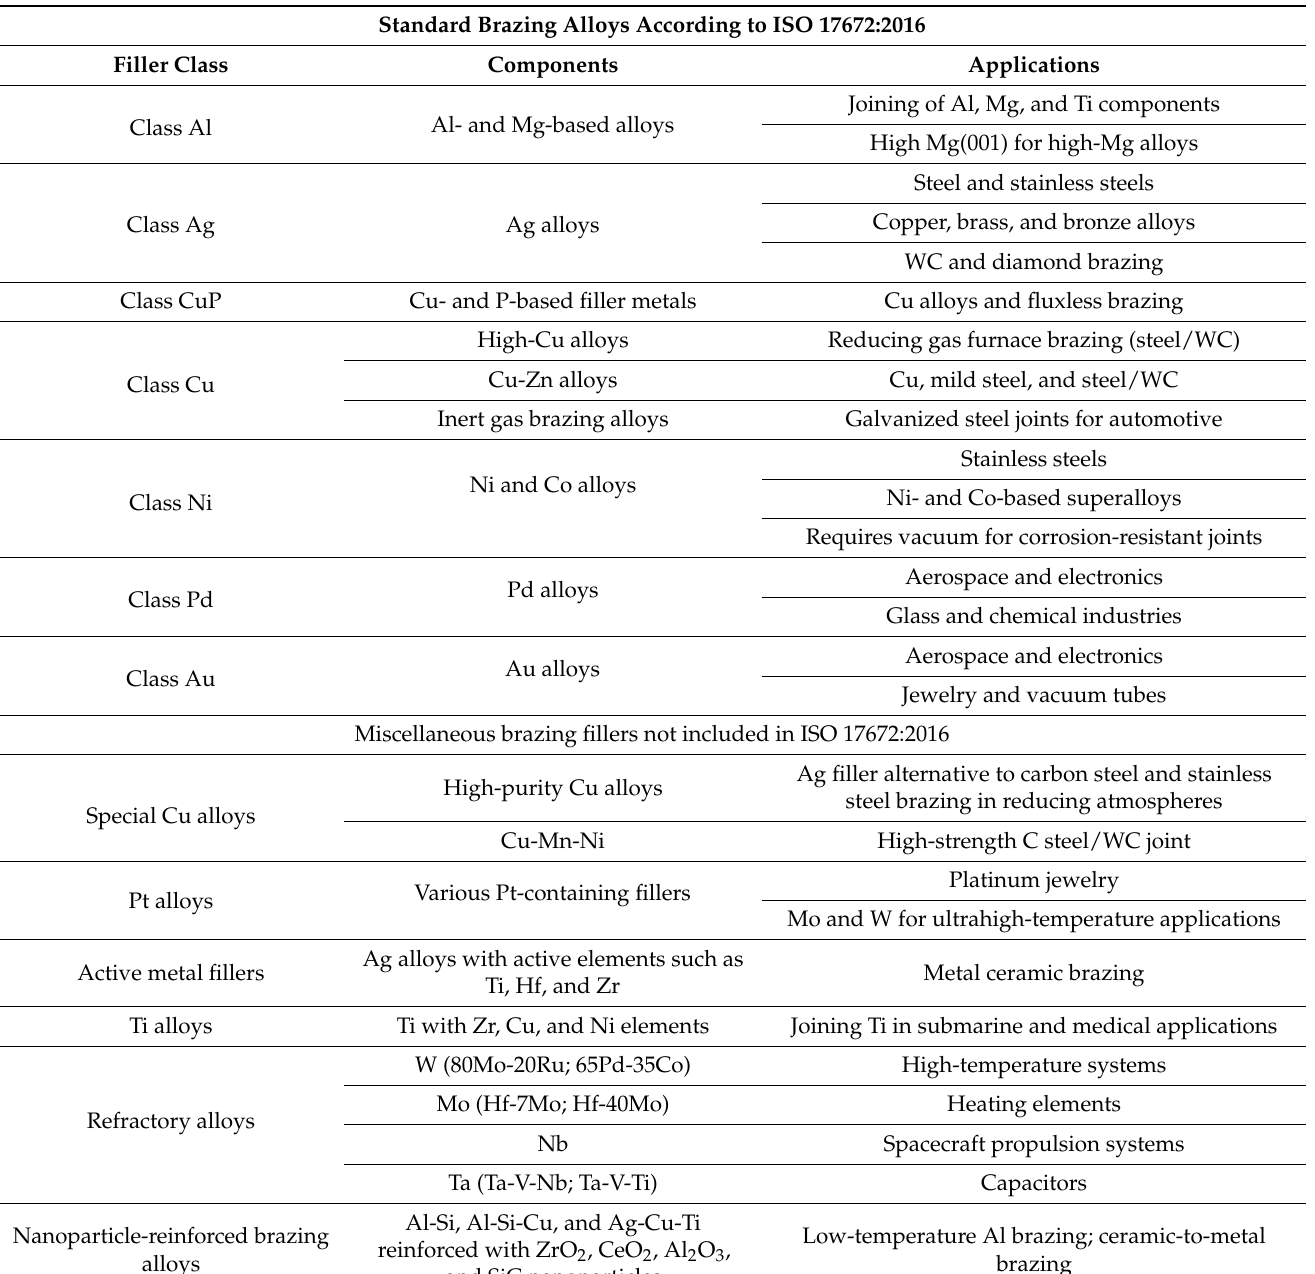
Table 2. Various classes of brazing alloys